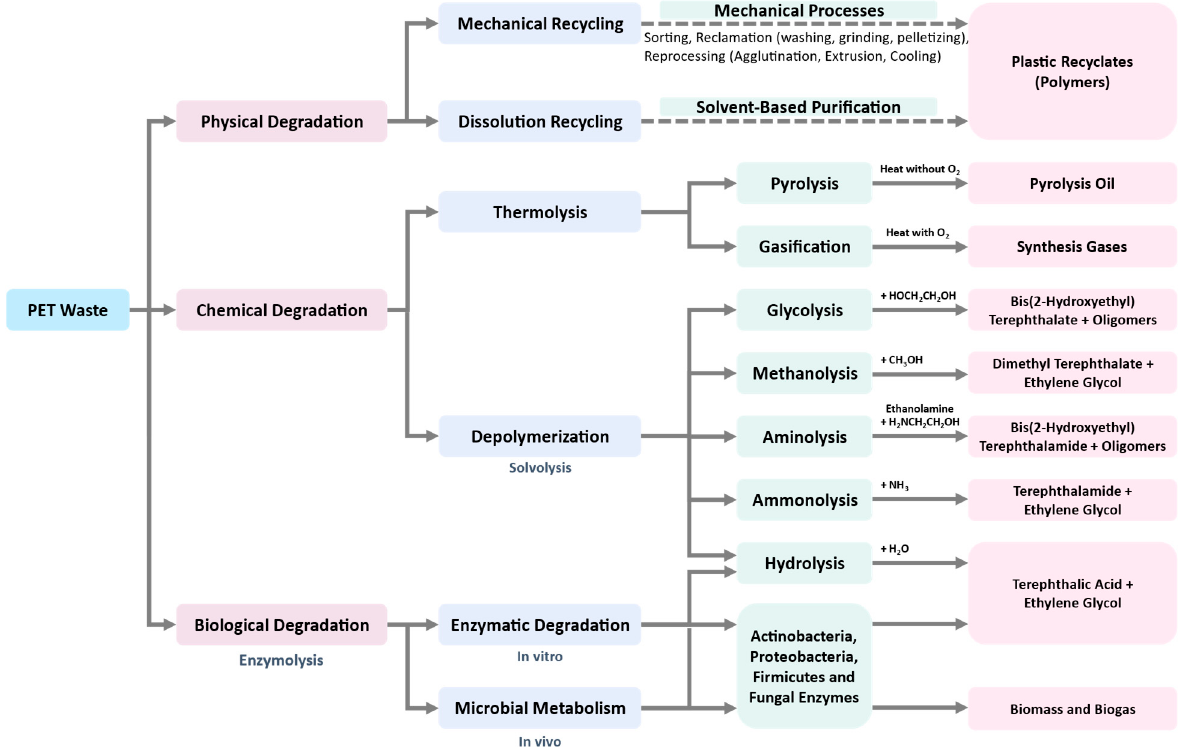
Figure 3. Physical, chemical, and biological approaches for PET recycling [2,54,55].